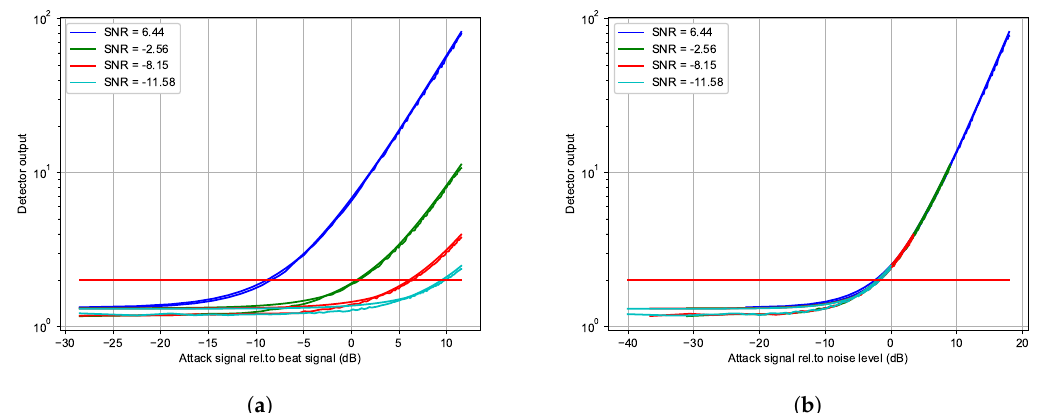
Figure 11. Test case eWGN. The horizontal orange colored line is the detection threshold. In ( a ) with respect to the beat signal level, and in ( b ) with respect to the noise level.